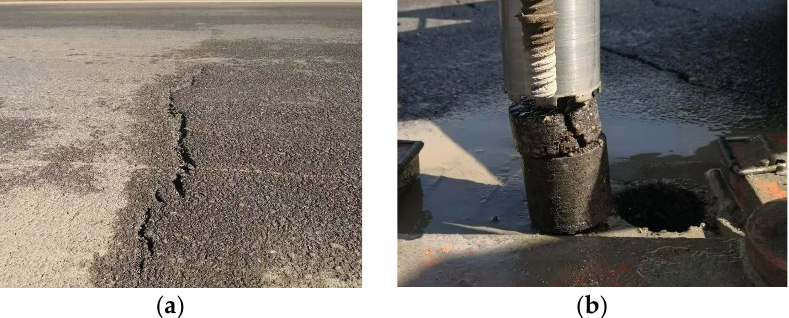
Figure 1. Interlayer slippage of PU mixture composite pavement. ( a ) Interlaminar slippage. ( b ) Interlaminar shedding.